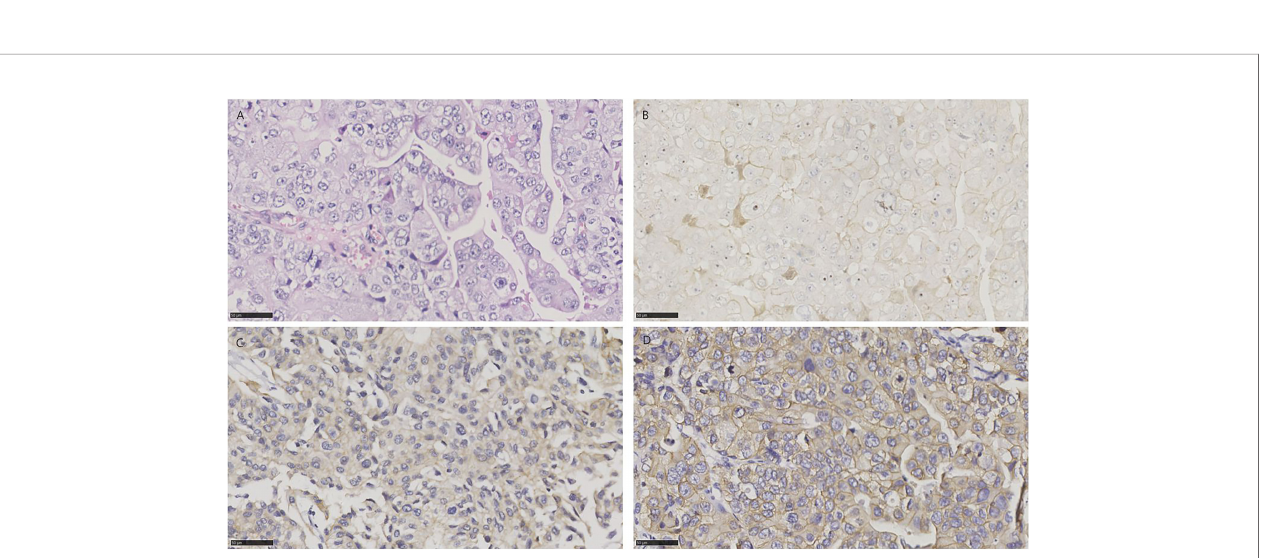
FIGURE 1 | Expression differences of NECTIN-4, TROP-2, and HER2 in different pathologic types of UC. (A) Expression differences of HER2, TROP-2, and NECTIN-4 in conventional UC and histologic variants. (B) Venn diagram of positive expression distribution of NECTIN-4, TROP-2, and HER2 in conventional UC and histologic variants. (C) Expression differences of NECTIN-4, TROP-2, and HER2 in luminal and basal/squamous subtype. (D) Venn diagram of positive expression distribution of NECTIN-4, TROP-2, and HER2 in luminal and basal/squamous